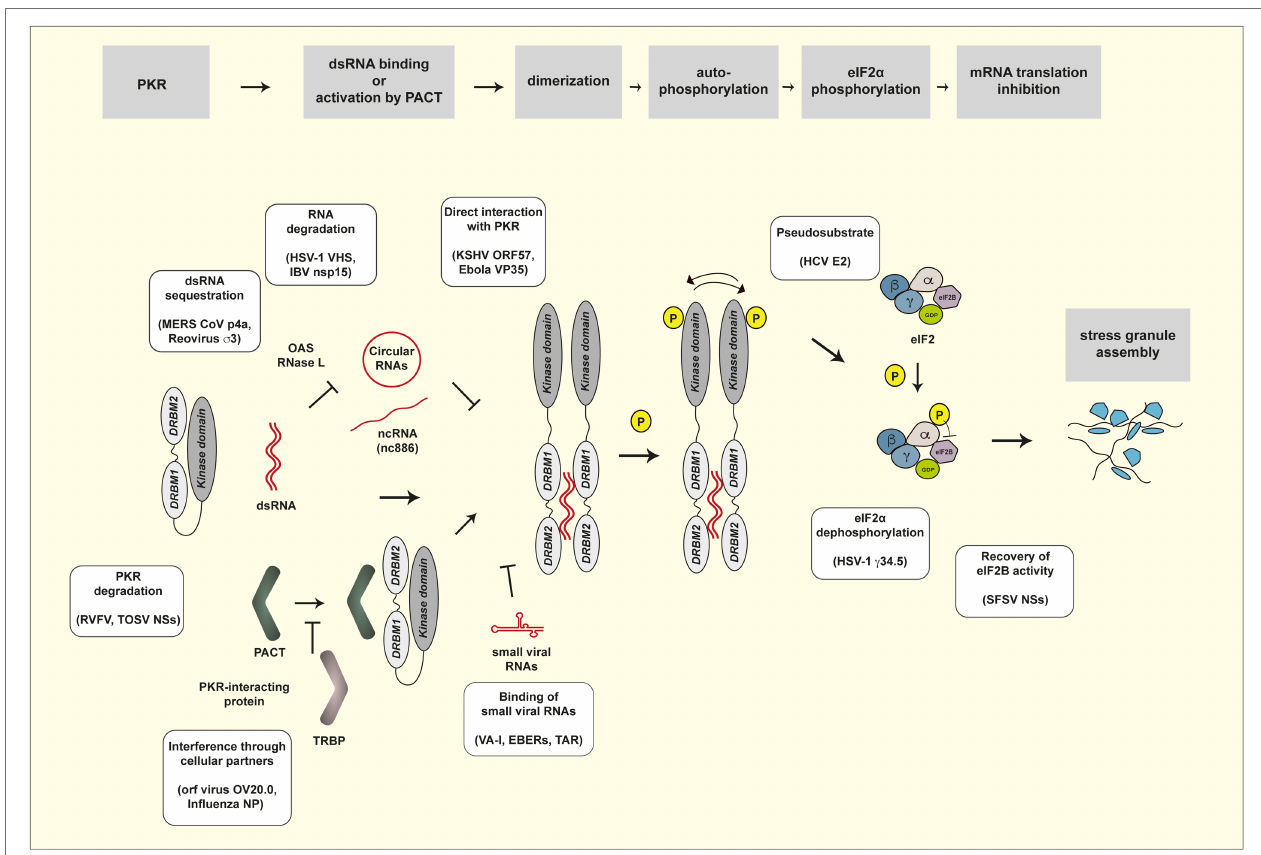
FIGURE 1 | PKR activation pathway and viral countermeasures. Steps of the PKR activation pathway are framed in gray. Viral evasion mechanisms are presented in yellow frames. See Table 1 for a list of viral products involved in evasion of PKR